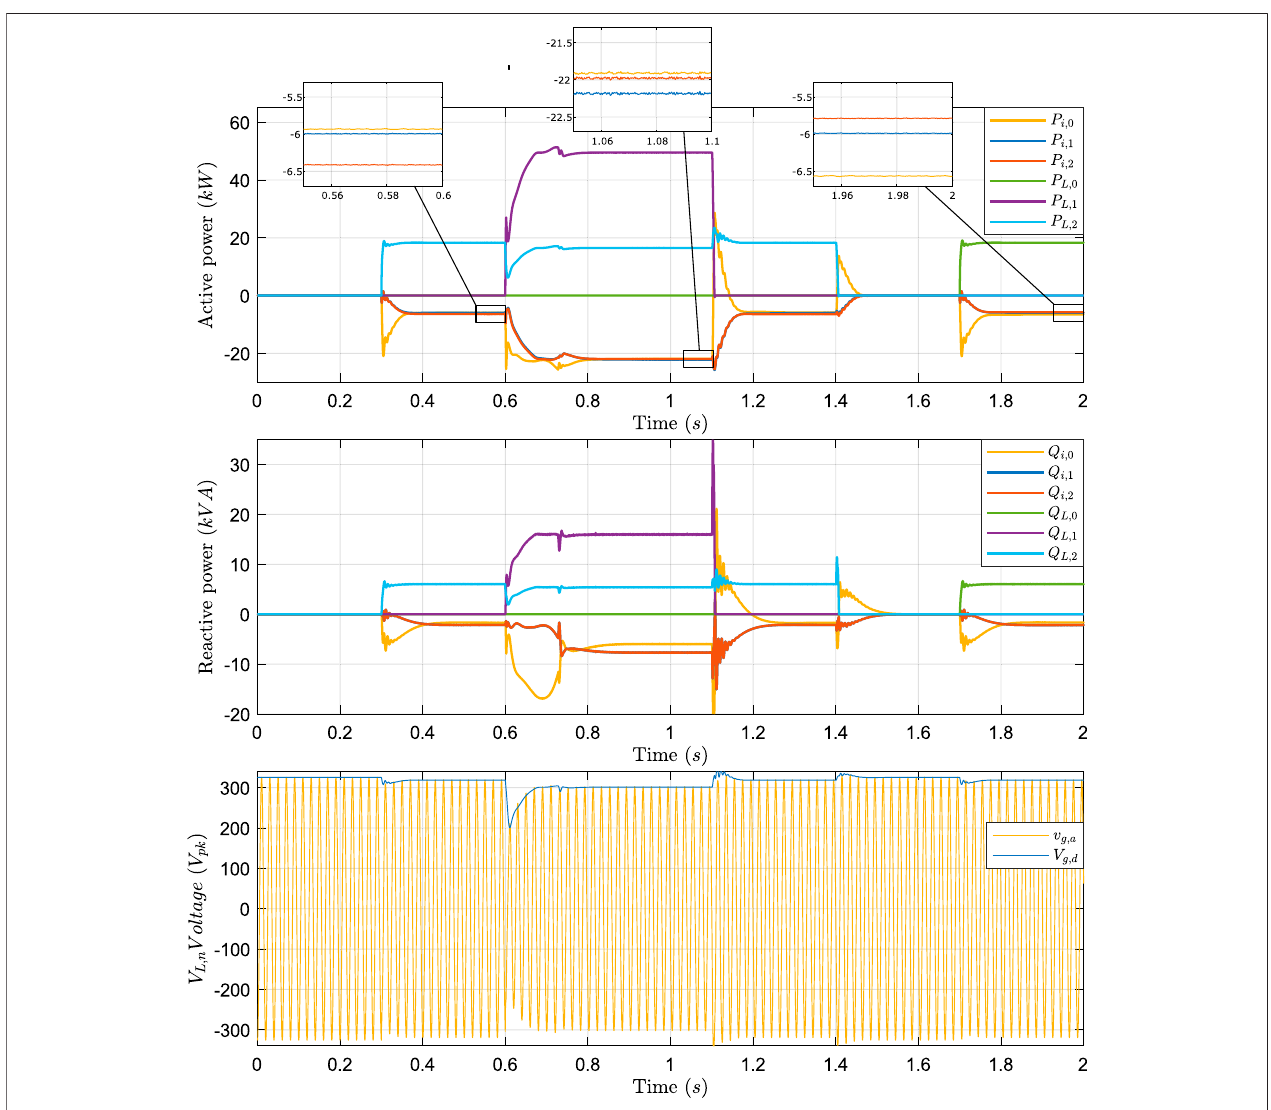
FIGURE 8 | Test one simulation results. Active power, reactive power, and AC voltage of reference phase.